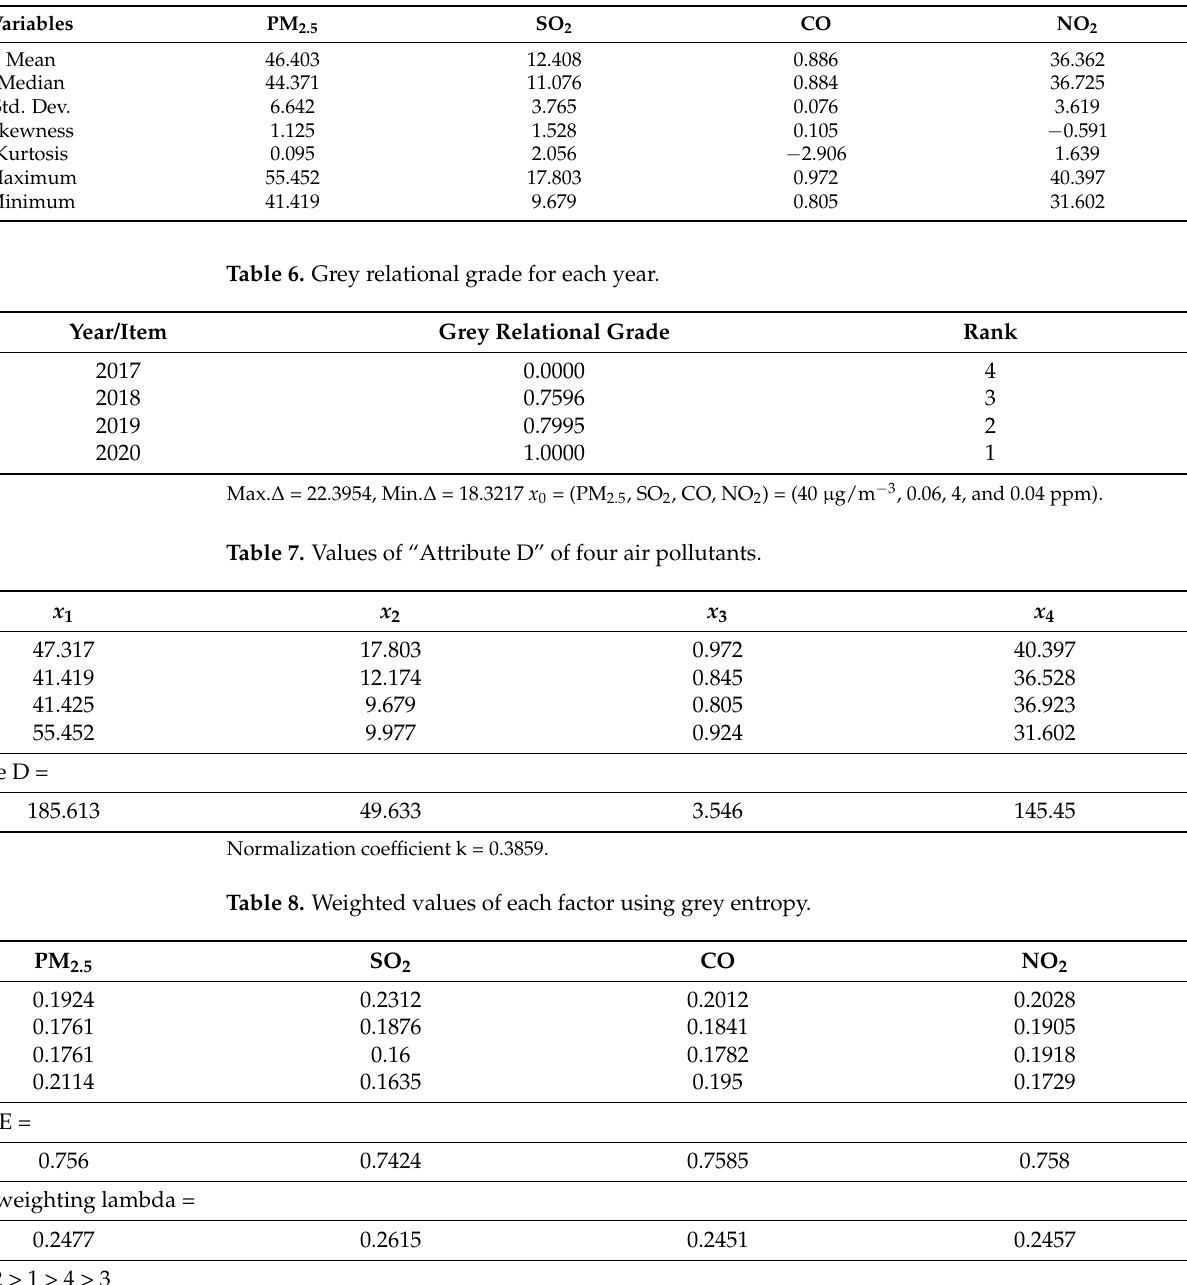
Table 5. Descriptive statistics of air pollutants.